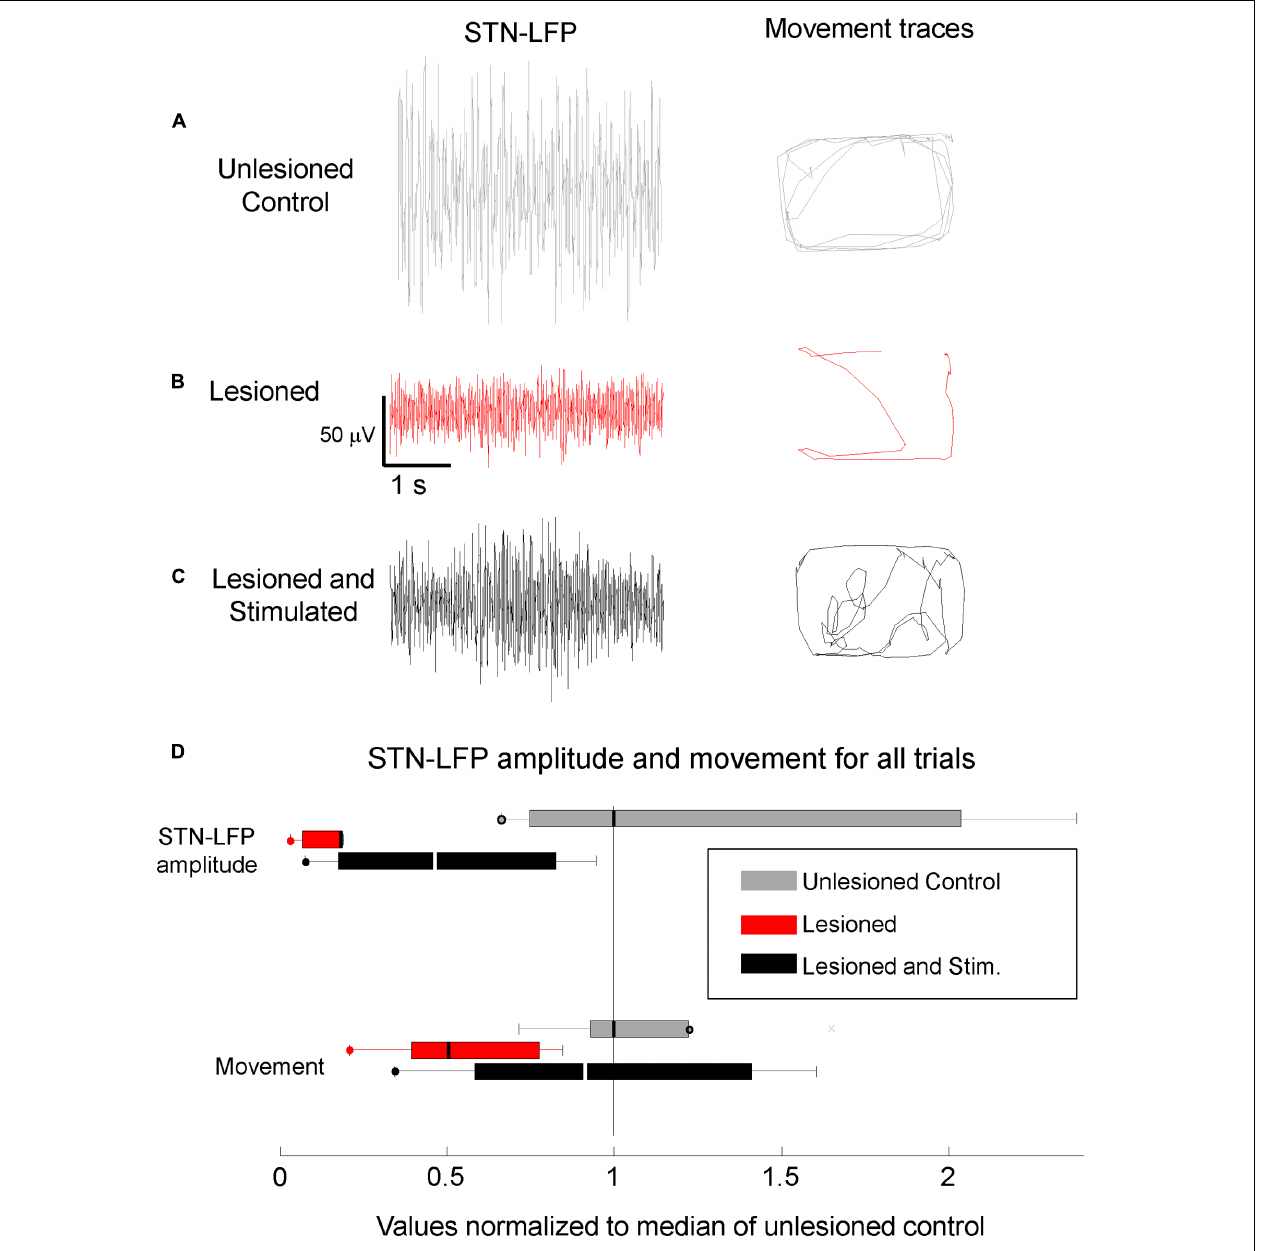
FIGURE 4 | Reduced STN-LFP amplitude and movement in lesioned mice were partially restored by M1-STN projection stimulation. Representative sample STN-LFP and movement for (A) unlesioned control, (B) 6-OHDA lesioned, and (C) M1-STN stimulated mice with 6-OHDA lesions, (D) Box-and-whisker plots summarizing STN-LFP amplitudes and movement for control, lesioned, and stimulated mice relative to control values. Circles at the end of whiskers indicate there are no data points outside the whisker. Note that the representative locomotion samples illustrate the typical amount of locomotion in each condition, not the pattern of movement. No consistent differences in the amount of time spent in the center versus the edges of the open field were observed between the stimulated lesioned mice and controls.